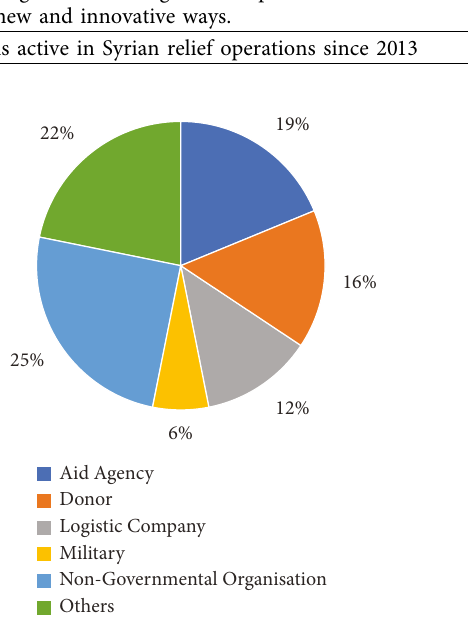
Figure 3: Professional profiles of